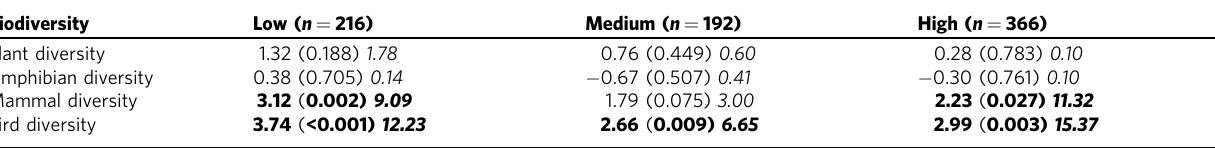
Table 4 Association between biodiversity and language diversity Biodiversity